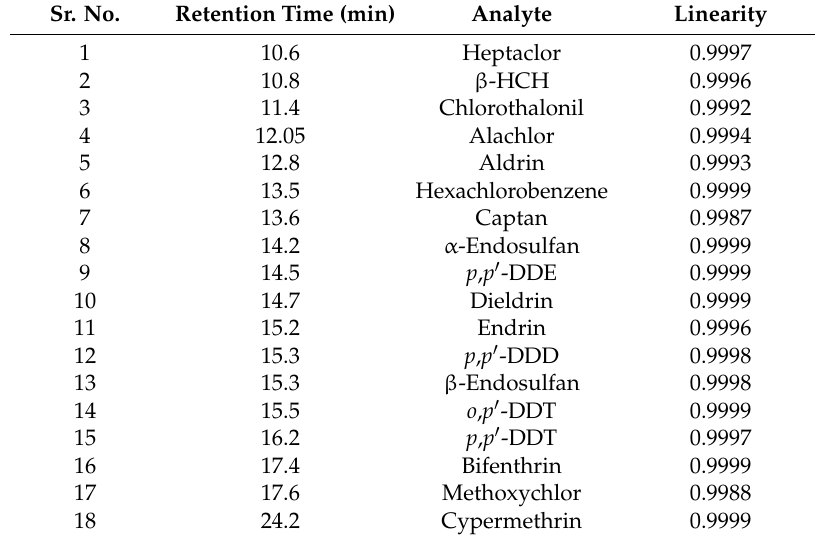
Table 2. Parameters and linearity results of GC-ECD analysis of 18